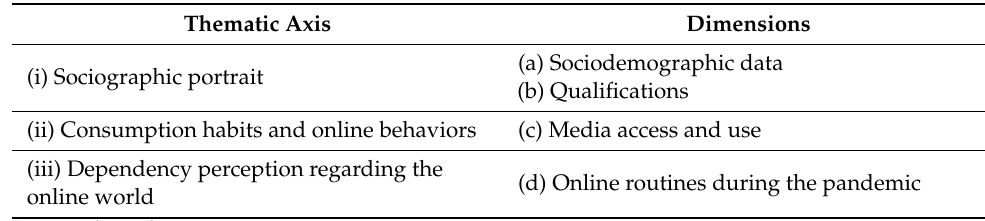
Table 1. Dimensions according to the thematic axis. Thematic Axis